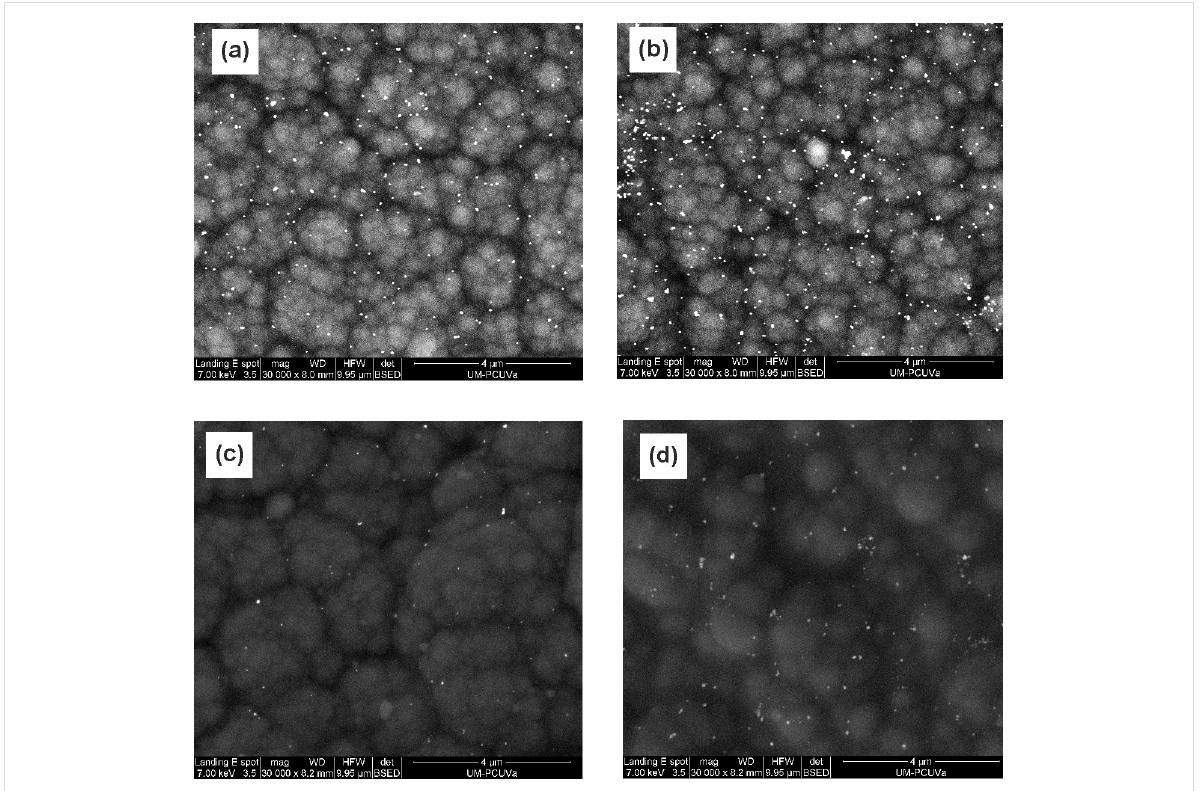
Figure 2: SEM images of Ppy/AuNP fims deposited on SS (a) Ppy/AuNP-T-CPss; (b) Ppy/AuNP-C-CPss; (c) Ppy/AuNP-T-CAss; (d) Ppy/AuNP-C-CAss.